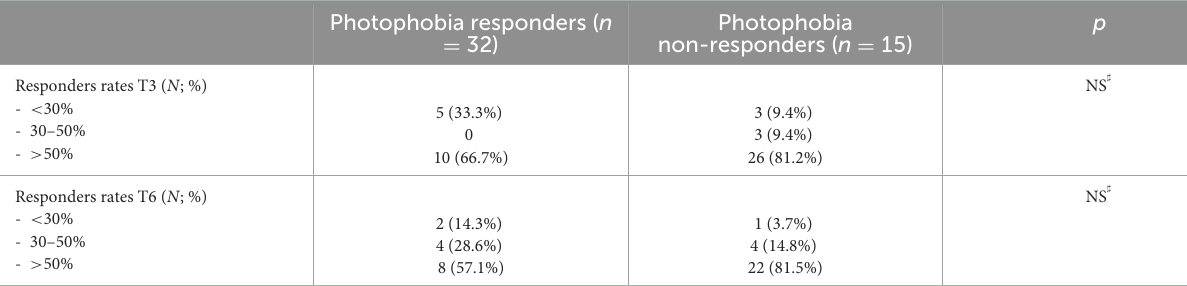
TABLE 2 Frequency of photophobia responders and non-responders according to the migraine responders